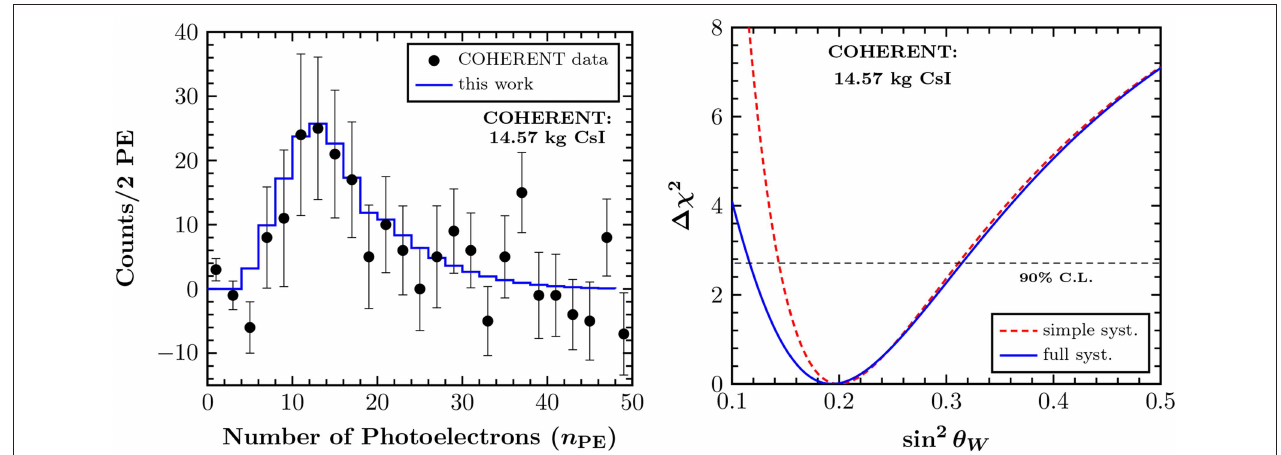
FIGURE 7 | Comparison between the simulated number of CE ν NS events and the experimental data by COHERENT (Left) and sensitivity of COHERENT on the weak mixing angle (Right) . Figure adapted from Papoulias and Kosmas [21] under the terms of the Creative Commons Attribution 4.0 International license.